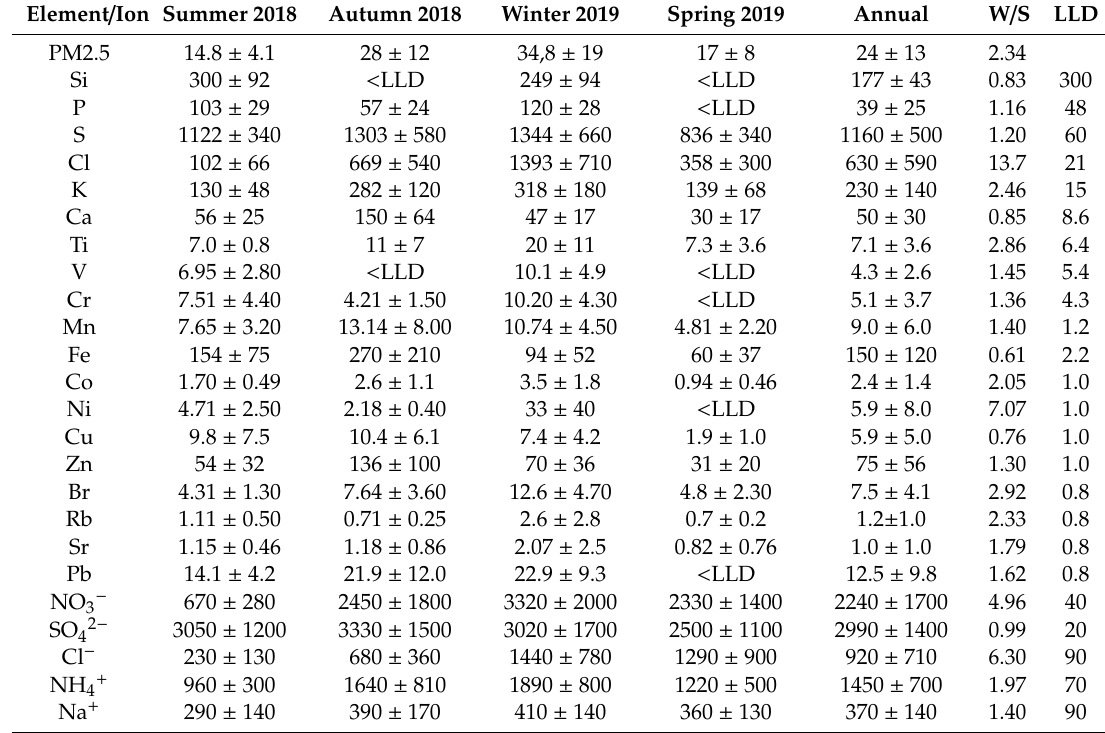
Table 1. PM2.5 (in µ g / m 3 ) elemental and ion concentrations (in ng / m 3 ) in Krakow. (W / S is Winter / Summer).